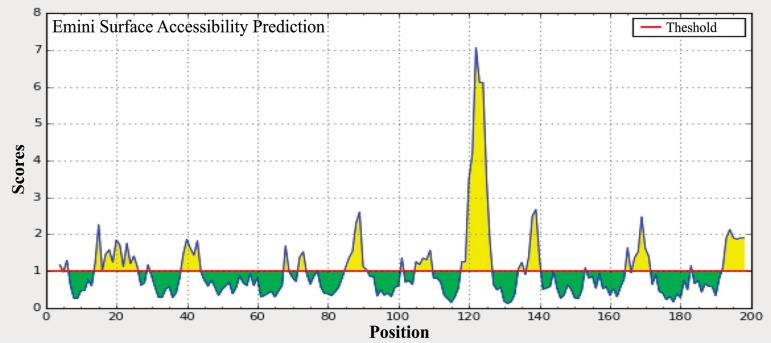
Emini surface accessibility prediction of Arabian camel HSPB-1 protein.The threshold value is 1.000. The regions above the threshold are antigenic and are shown in yellow.